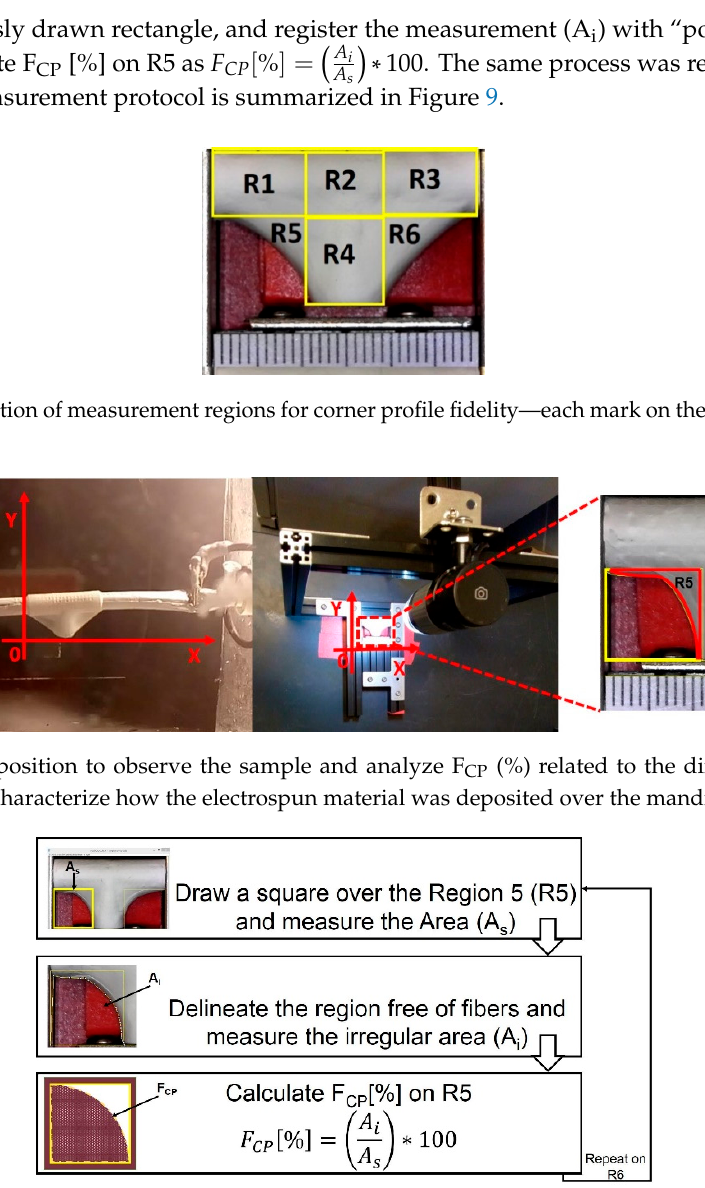
Figure 9. Measuring process to calculate corner profile fidelity F CP (%) on regions R5 and R6 of the vascular graft membrane with ImageJ